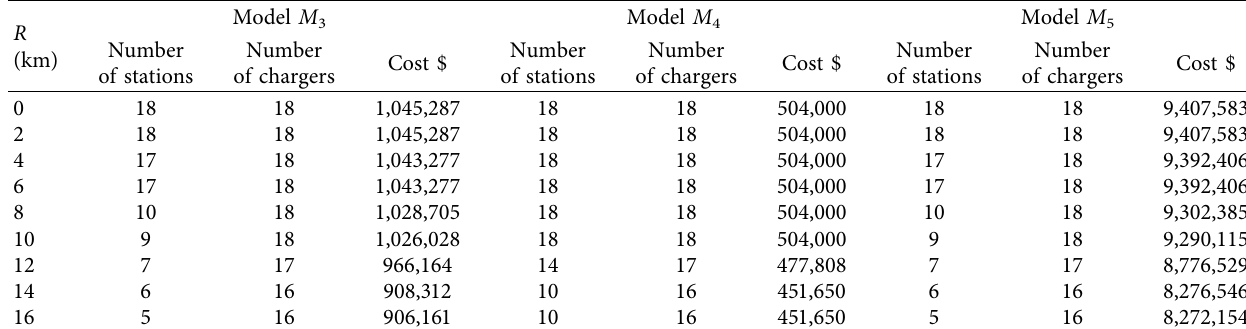
Figure 5: Model M 4 output variation. Table 4: Te impact of the coverage radius on the results of models M 3 , M 4, and M 5 .